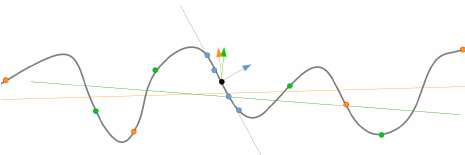
Figure 2. Sampling a point cloud at different scales (denoted by colors) reveals different properties of the underlying surface – here different surface normals (colored arrows). Multi-scale fea- ture extraction therefore improves